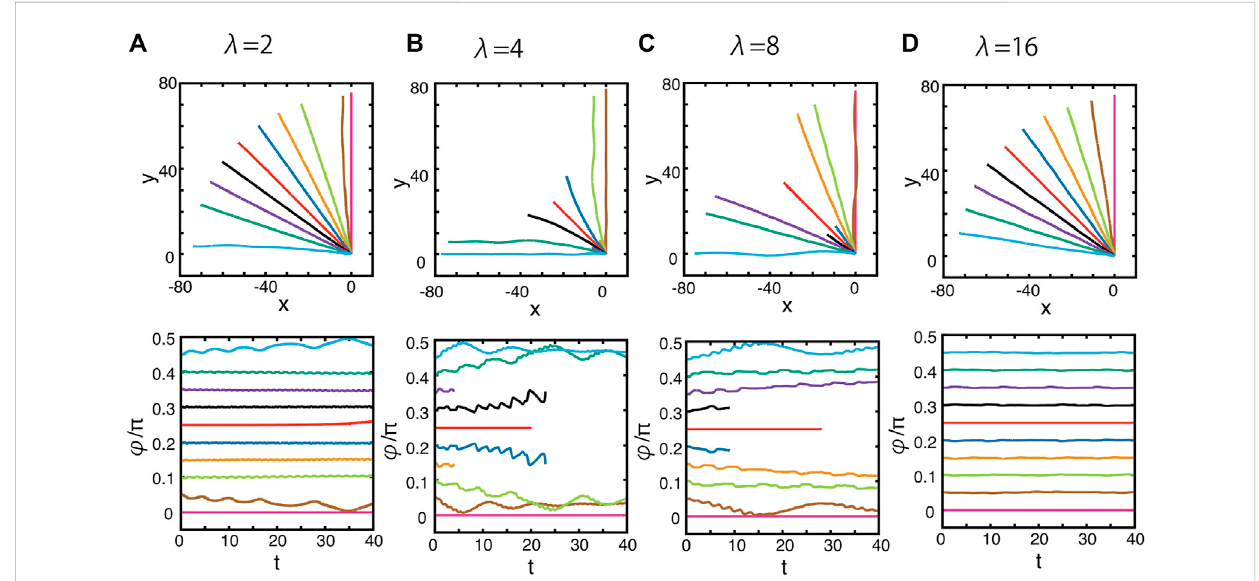
FIGURE 9 Dynamics of the squirmer near a surface with the doubly periodic sinusoidal wave topography of Eq. 6, as depicted in Figure 2C. The surface topography amplitude is given by A = 0.1, and the wavelength is unchanged from previous plots, but is no longer given by λ = 2 π / k where k is the wavenumber of the sinusoidal functions in Eq. 6, since these functions are squared. Hence, to preserve wavelength at 1, 2, 4, 8 length units in the respective columns,we take (A) λ =2, (B) λ = 4, (C) λ =8, and (D) λ = 16 onmoving fromleft to rightacross the fi gure. (Top panels) theprojections of thesquirmertrajectoriesontothe x – y planewithdifferentinitialorientationangles, φ ,asde fi ned via Figure5.Theseinitialanglesmaybeinferredfromthe initial tangents of the plotted projected trajectories. (Bottom panels) the time evolution of the orientation angle φ . Different colours index different initial